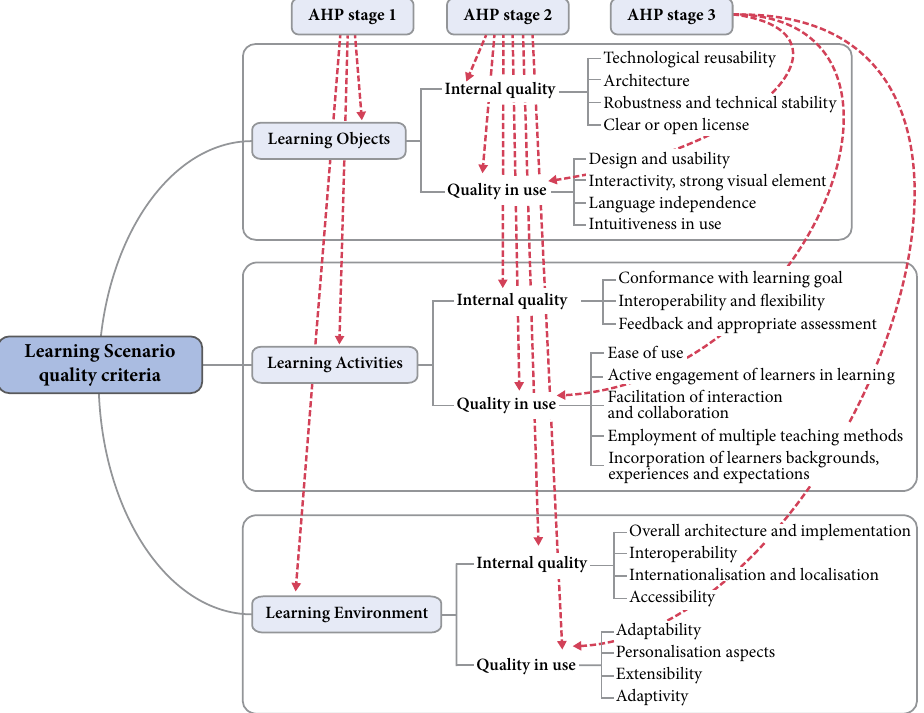
Fig. 1. Quality criteria of learning scenario and aHP application